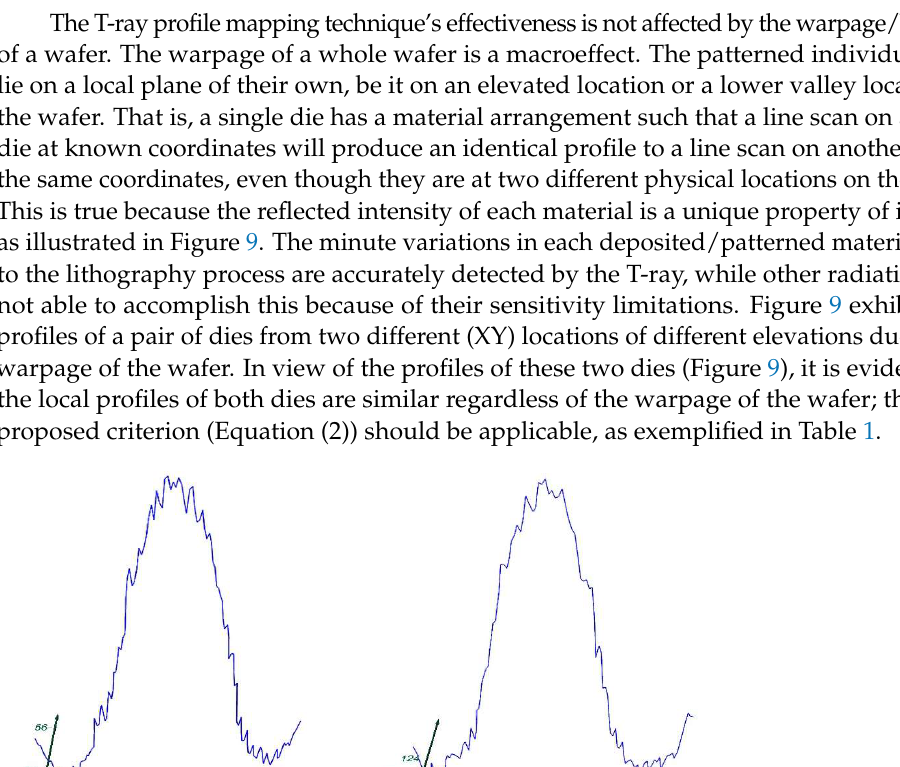
Figure 9. Profiles of a pair of dies from two different (XY) locations.